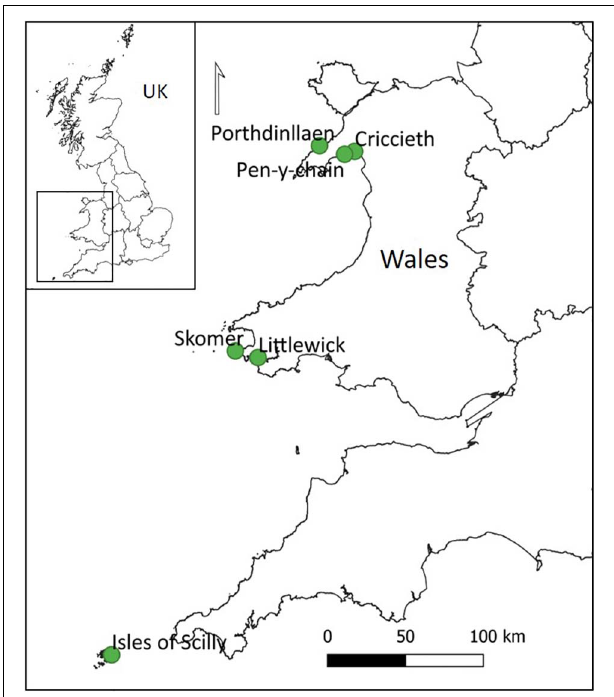
FIGURE 1 | Locations of seagrass sites surveyed around Wales and on the Isles of Scilly, United Kingdom.